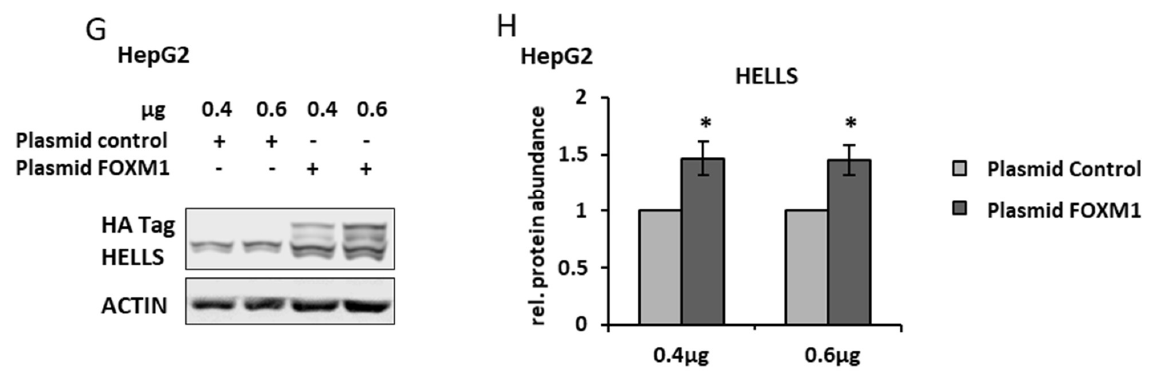
Figure 6. P53/21 dependent HELLS repression requires downregulation of FOXM1: ( A ) HepG2 cells were transfected with either control siRNA (AS) or two different FOXM1 siRNAs (FOXM1#1 and #2). Cell extracts were analysed by immunoblotting with indicated antibodies. Densitometric quantification (d. q.) of HELLS normalized to control siRNA. ( B ) HepG2 cells as described in ( A ) with HELLS and FOXM1 transcript levels measured by qRT-PCR. Standard deviations are derived from three biological replicates. ( C ) HLE cells as described in ( A ). ( D ) HLE cells as described in ( C ) with HELLS and FOXM1 transcript levels measured by qRT-PCR. Standard deviations are derived from three biological replicates. ( E ) HLF cells as described in ( A ). ( F ) HLF cells as described in ( E ) with HELLS and FOXM1 transcript levels measured by qRT-PCR. Standard deviations are derived from three biological replicates. ( G ) HepG2 cells were transfected with either a control or FOXM1 plasmid in different concentrations as indicated and were subjected to immunoblotting with indicated antibodies. ( H ) Relative densitometric quantification of immunoblots derived from three independent experiments and normalized to the DMSO control as described in ( G ). * p < 0.05, ** p < 0.01, *** p < 0.001 (Student’s t -test). Data are presented as mean ± stdv.